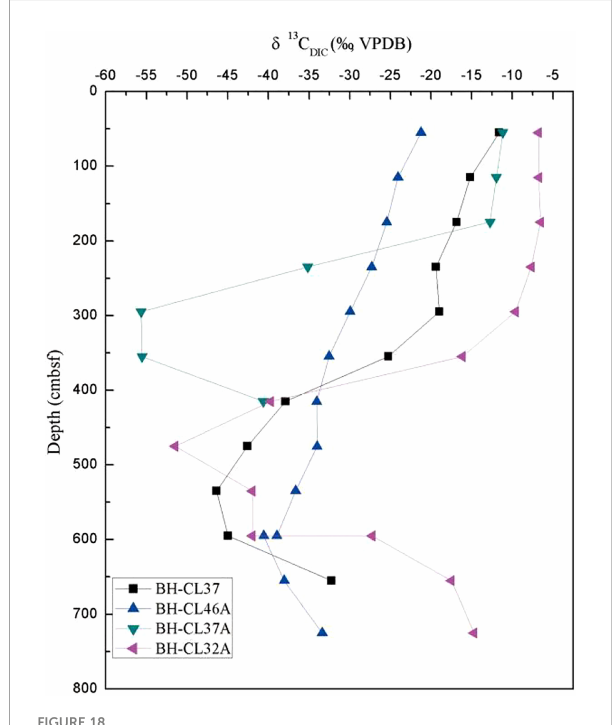
FIGURE 18 Comparison of d 13 C DIC with depth in different sediment